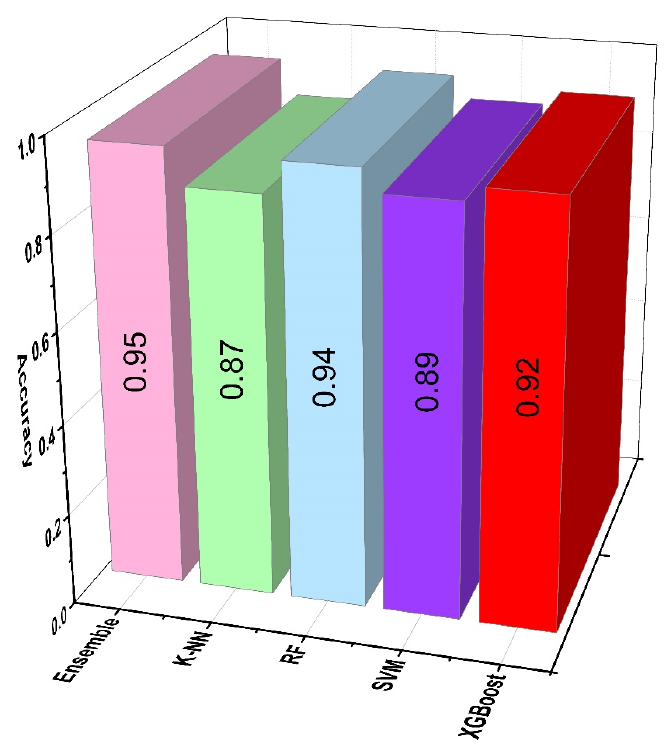
Figure 7. Boxplot of the four various models used for data analysis.